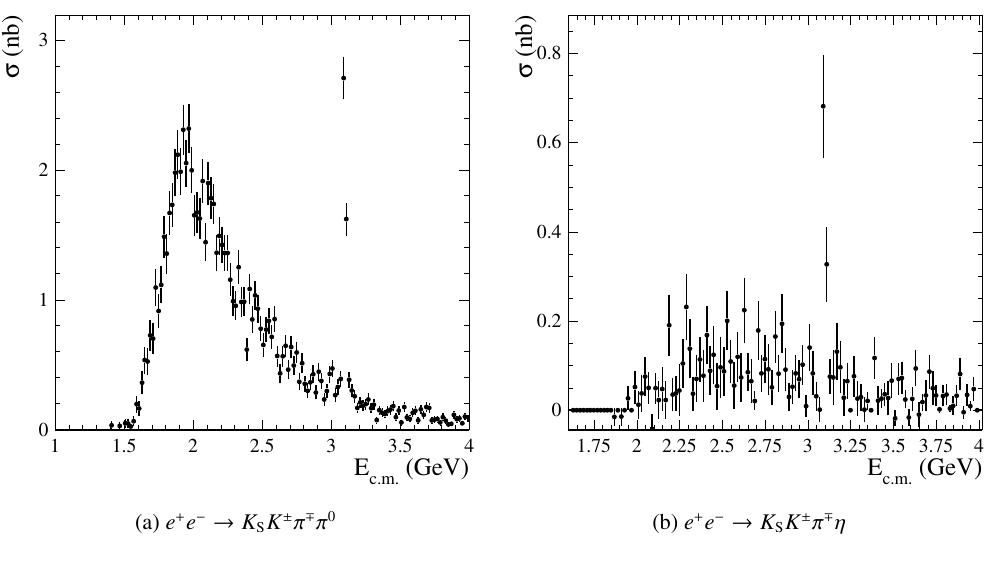
Figure 5: The cross sections containing charged kaons